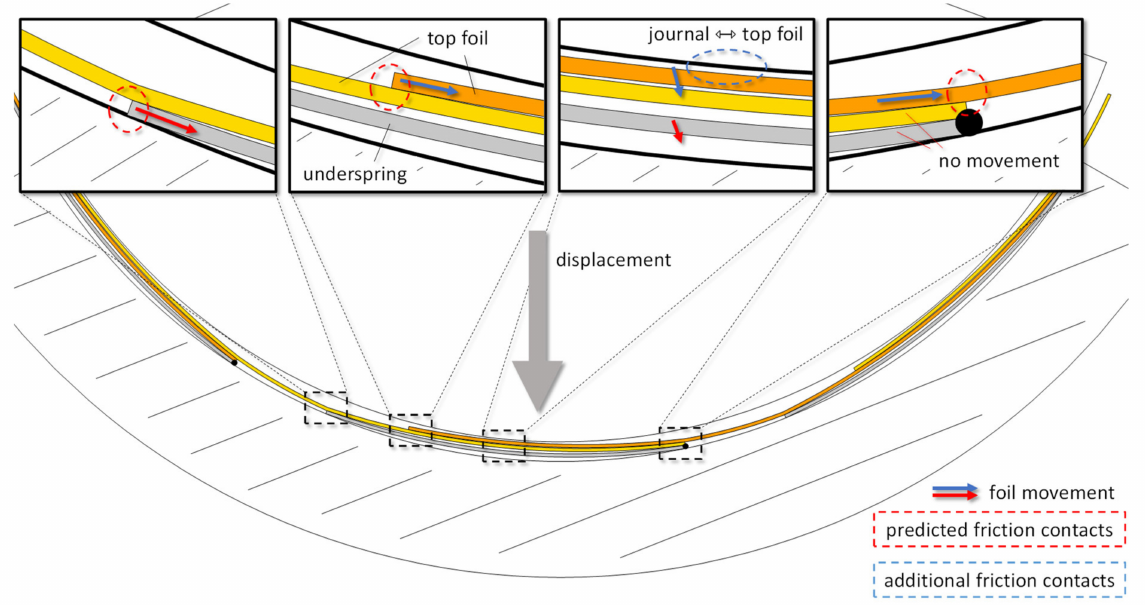
Figure 5. Contact zones between the journal, the foils and the bearing ring (true to scale).